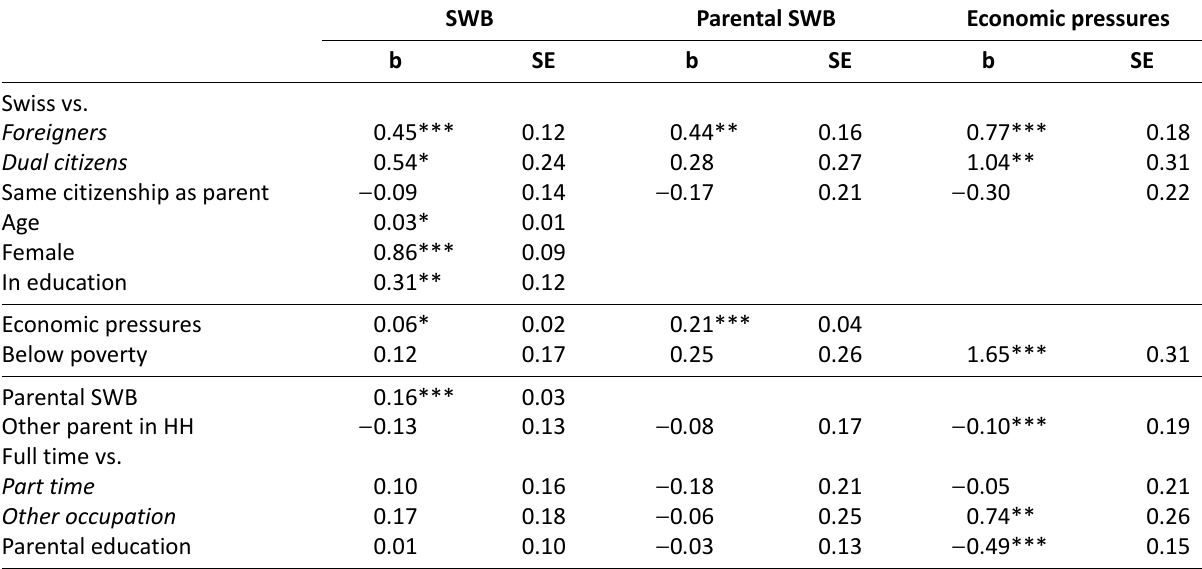
Table 2. Results of path model (respondents and their